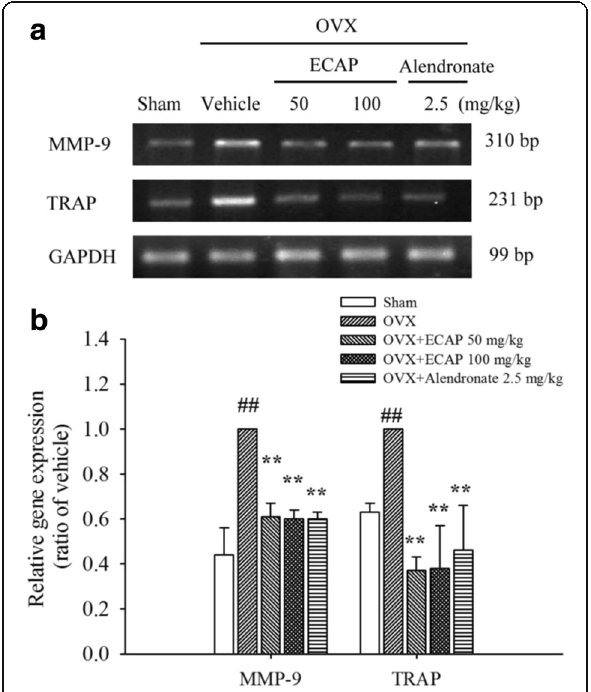
Fig. 6 The expression of MMP-9 and TRAP RT-PCR on the metaphysis of the right tibiae in OVX mice. a Fragments of MMP-9, TRAP and GAPDH were amplified by RT-PCR. b The expression levels of MMP-9 and TRAP mRNA were measured and quantified densitometrically after 4 weeks in OVX mice. Each value represents the mean ± SD. ( n = 8). ## P < 0.01 compared with shame group; * P < 0.05, ** P < 0.01 compared with OVX + Vehicle